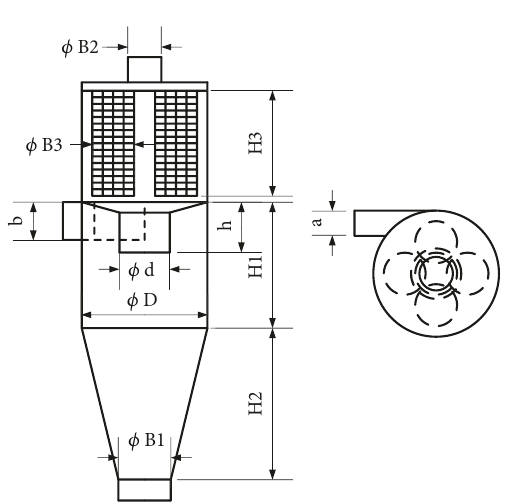
Figure 2: Diagram of combined separator